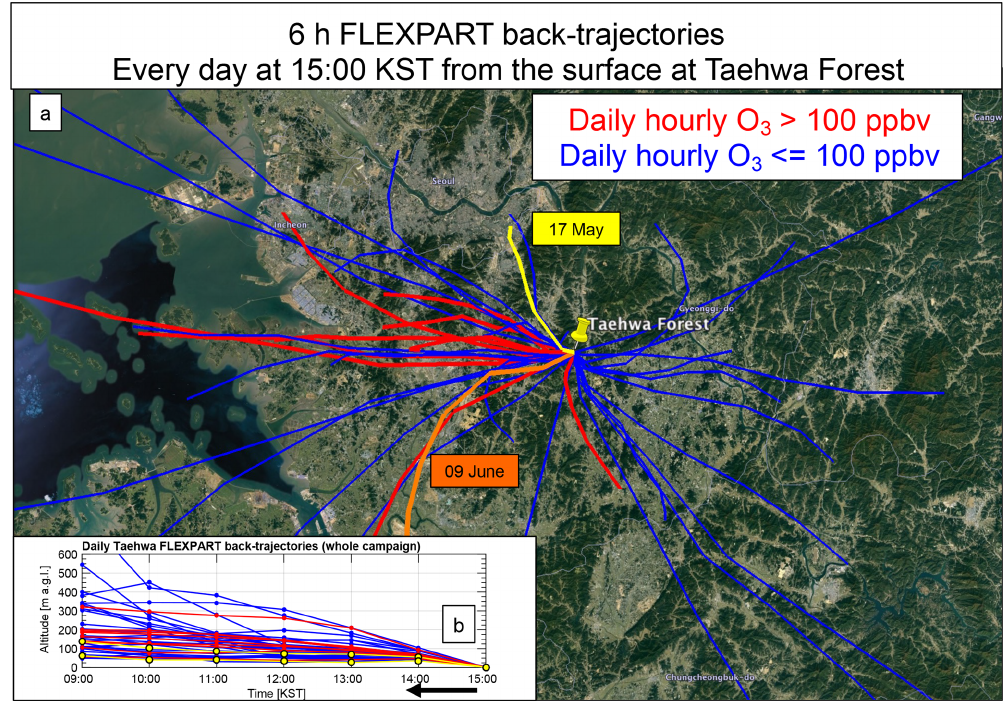
Figure 2. Daily 6h FLEXPART back-trajectory (a) spatial and (b) vertical locations for all parcels initialized at 15:00KST at TRF throughout the KORUS-AQ campaign. The two case studies are 17 May (yellow) and 9 June